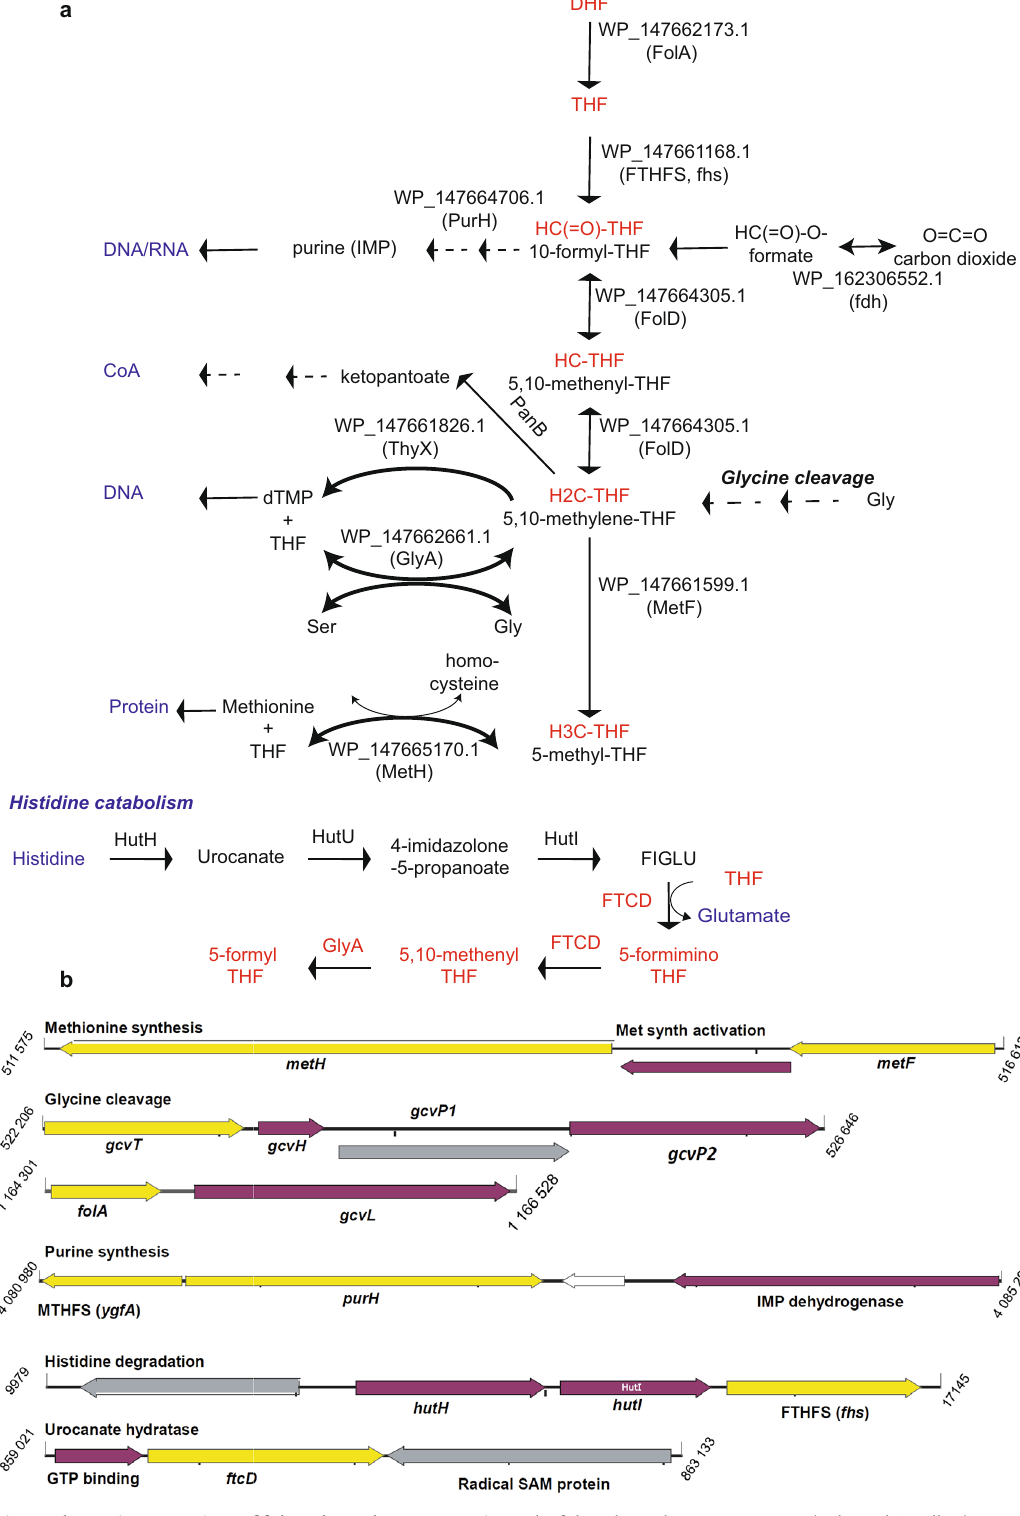
the folate-dependent Psyn enzymes (indicated in yellow) as suggested by the genomic context analyses. Purple and gray refer to genes functionally linked with folate-dependent enzymes. All these genes are moderately expressed in Psyn (Supplementary Fig. 2) For additional discussion, see